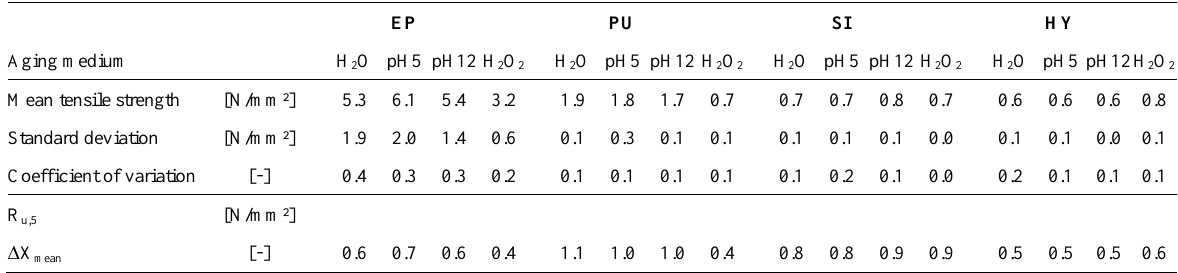
Table 2: Tensile strength after storing in different chemical aging